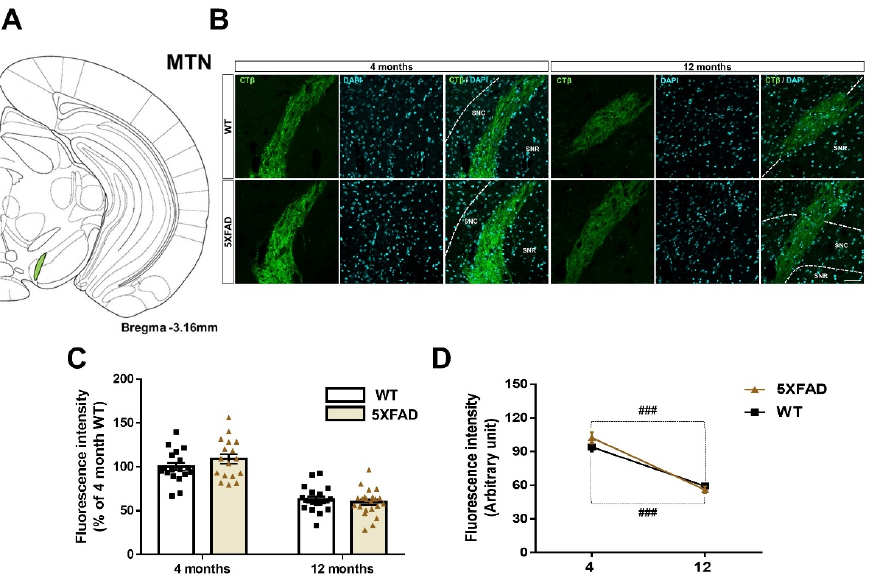
Figure 7. Neuroanatomic tract tracing of the retina-medial terminal nucleus of the accessory